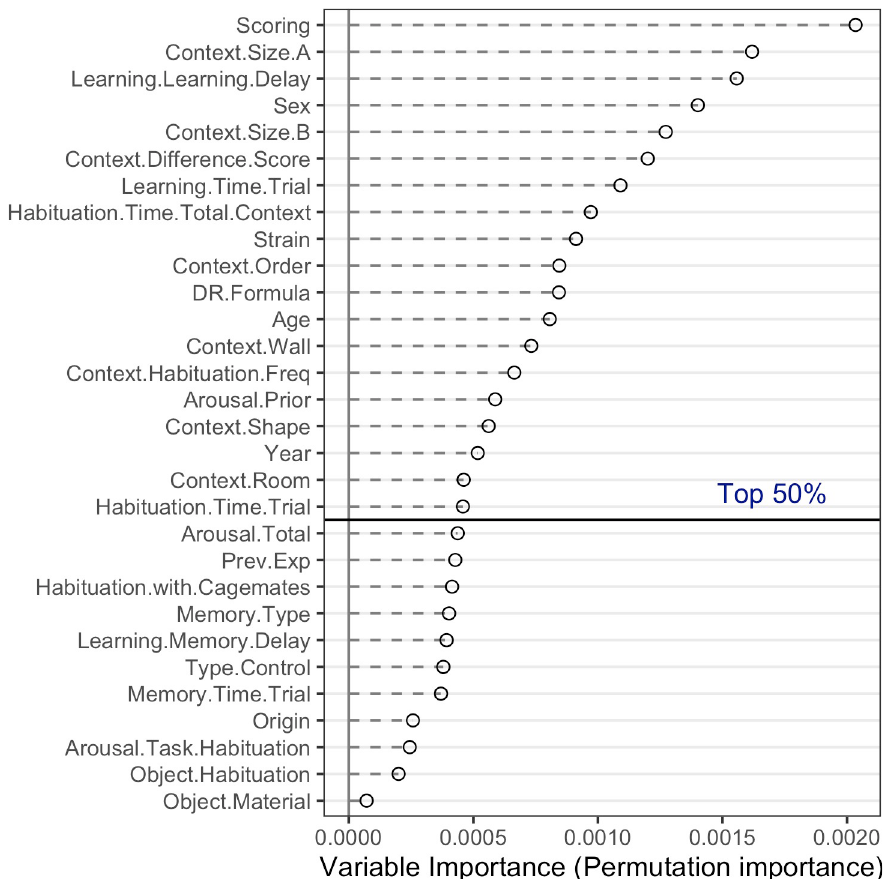
Fig 6. Relative importance of potential moderators based on ‘permuted variable importance’ in the random forest-based meta-analyses. Moderators above the horizontal line belong to the top 50%. Full definitions of variables and sum scores can be found in A2 and A5 Appendices in S1 File